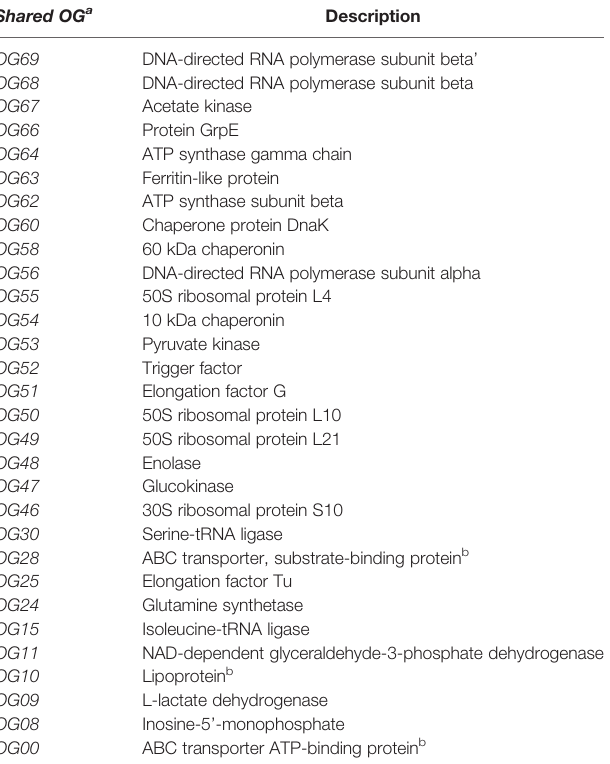
bacterial component may perturb the entire ecosystem and lead to a deep rearrangement in the community composition, with possible onset of different diseases. TABLE 1 | Description of EV-derived proteins included in orthogroups (OG) shared between S. aureus , E. faecium , E. faecalis , and G. vaginalis . Shared OG a